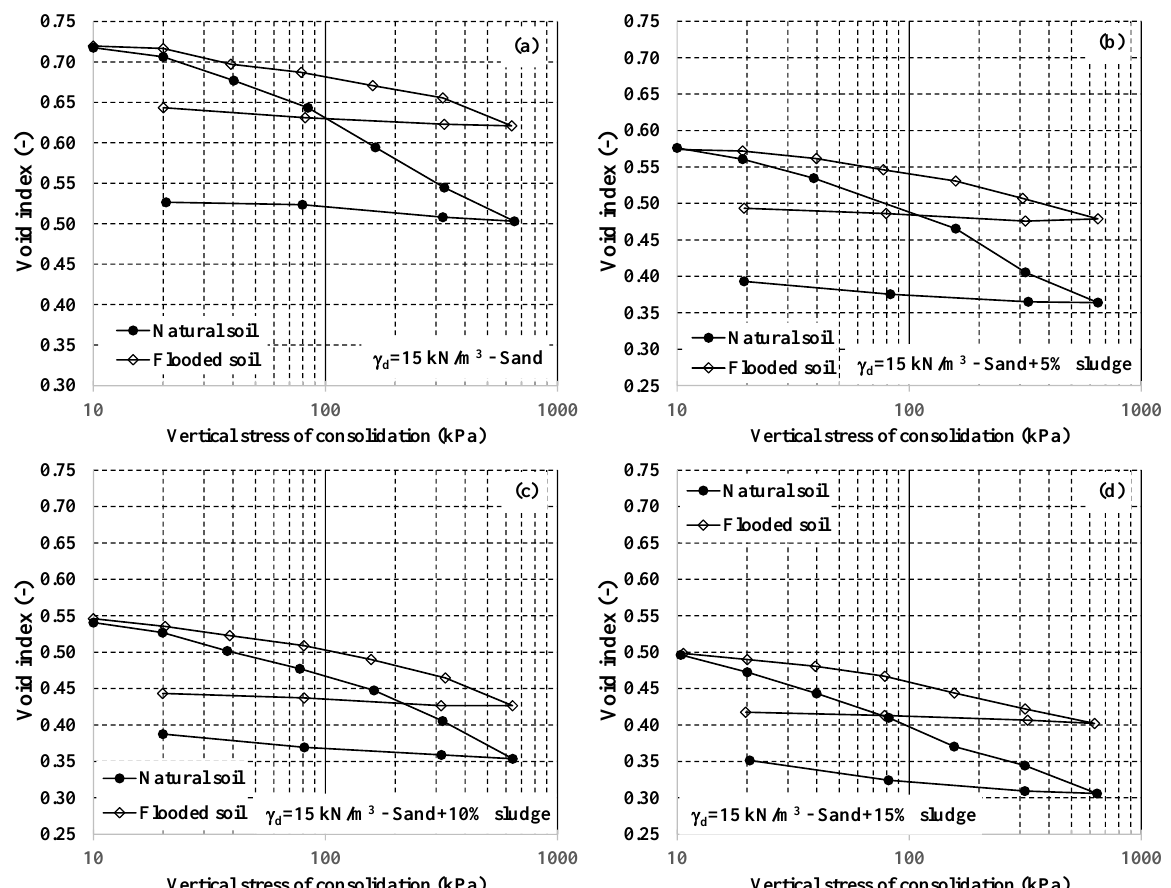
Figure 13. Variation of the void index with the vertical stress of consolidation obtained through double oedometer tests, for dry apparent specific weight of 15.0 kN/m 3 : ( a ) sand, ( b ) sand plus 5% sewage sludge, ( c ) sand plus 10% sludge, ( d ) sand plus 15% sludge.